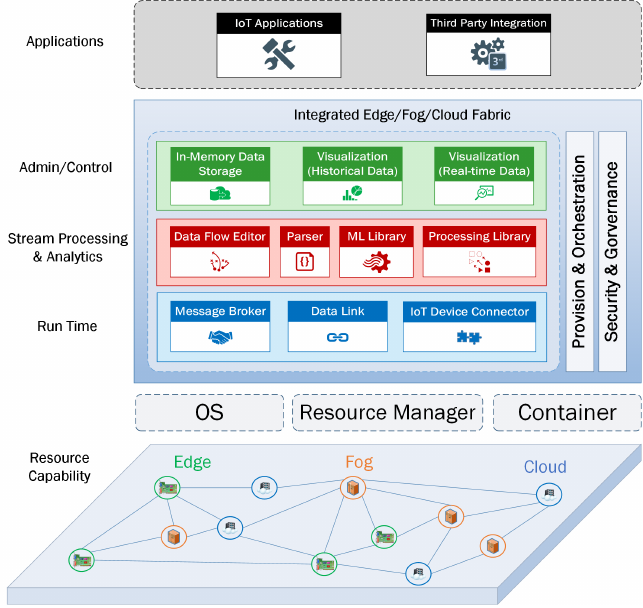
Figure 2. The proposed Internet of Things (IoT) architecture for our Analytics Everywhere